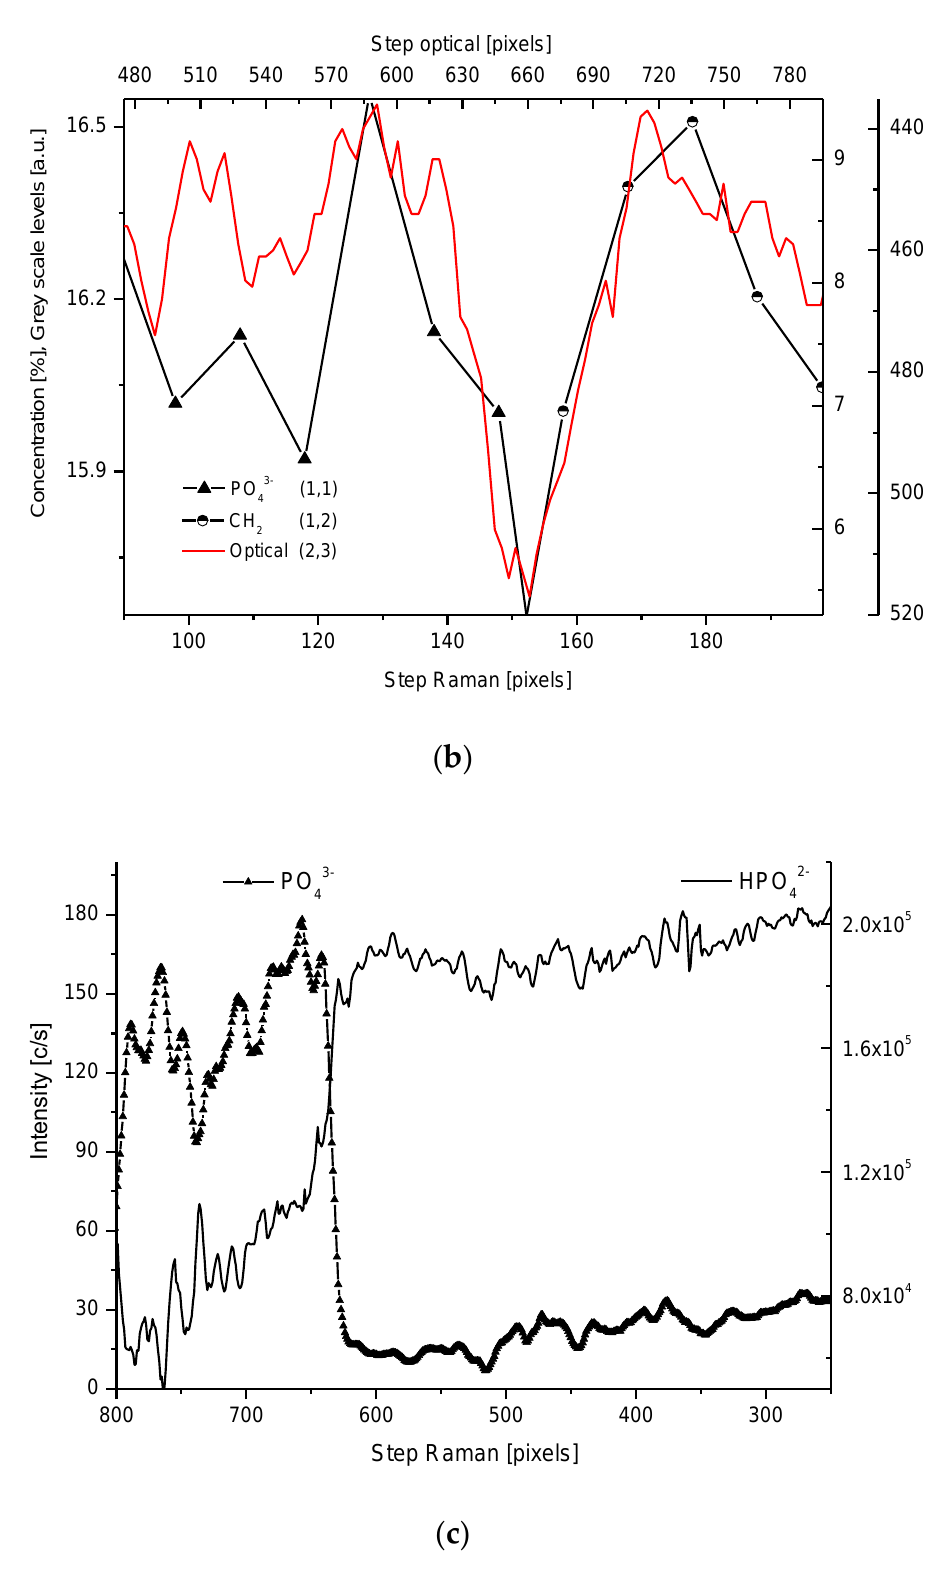
Figure 3. ( a ) Results of µ -Raman measurements around the DEJ. PO 4 3 − - ν 1 oscillation; CH 2 - ν symmetric oscillation; NH line; CO 3 2 − , sub. B; 1 step = 1.61 µ m; ( b ) Outline of DEJ space with optical and Raman PO 4 3 − and CH 2 signals. ( c ) Divergent spatial profiles of PO 4 3 − and HPO 4 2 − ions, with visible DEJ.